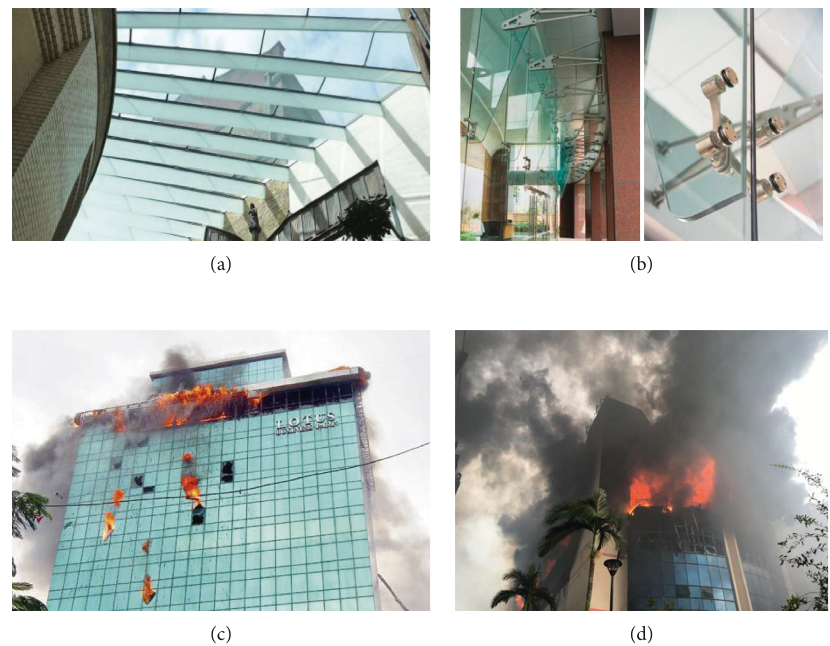
Figure 1: (a)-(b) Typical structural glass applications in buildings and (c)-(d) examples of recent fire event